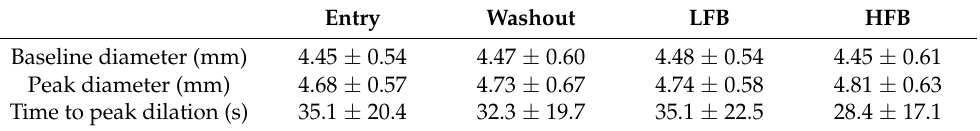
Table 2. Baseline and peak brachial artery diameters and time to peak dilation at each study time point. Entry Washout LFB HFB Figure 1. ( A ) Gated flow-mediated dilation. ( B ) Allometrically scaled flow-mediated dilation. Val- Baseline diameter (mm) 4.45 ± 0.54 ues are percent dilation for entry, washout, LFB intervention, and HFB intervention. Cross-over Time to peak dilation (s) 35.1 ± 20.4 32.3 ± 19.7 35.1 ± 22.5 28.4 ± 17.1 design ( n = 23); values represent mean ± SD. Means without a common letter differ, p < 0.05.